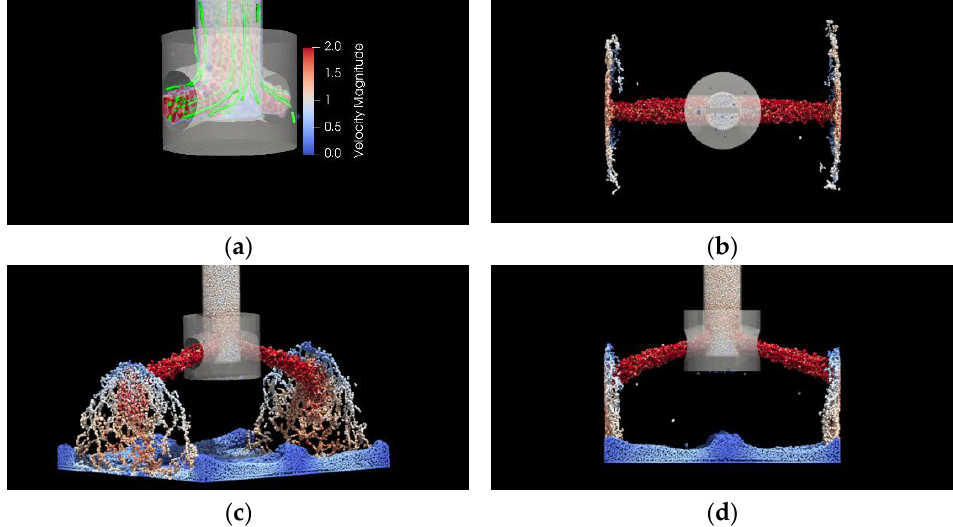
Figure 11. FBFD SEN model without a pool and with a flow separator. Description of each panel in the figure is the same as in Figure 10.